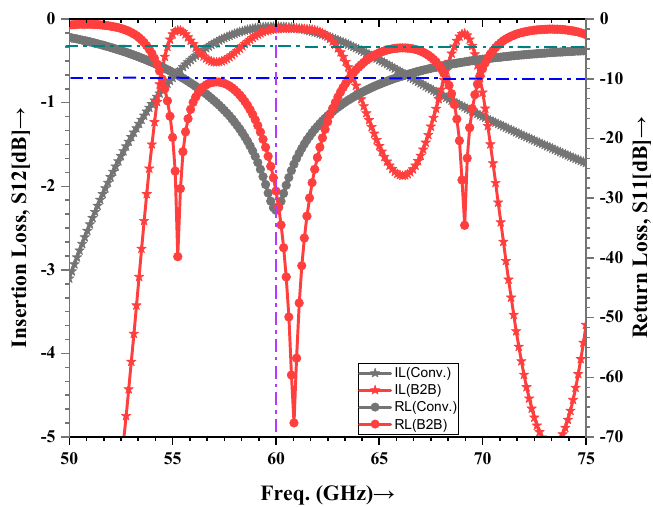
Figure 6. V-band back-to-back MS-to-WG transition.